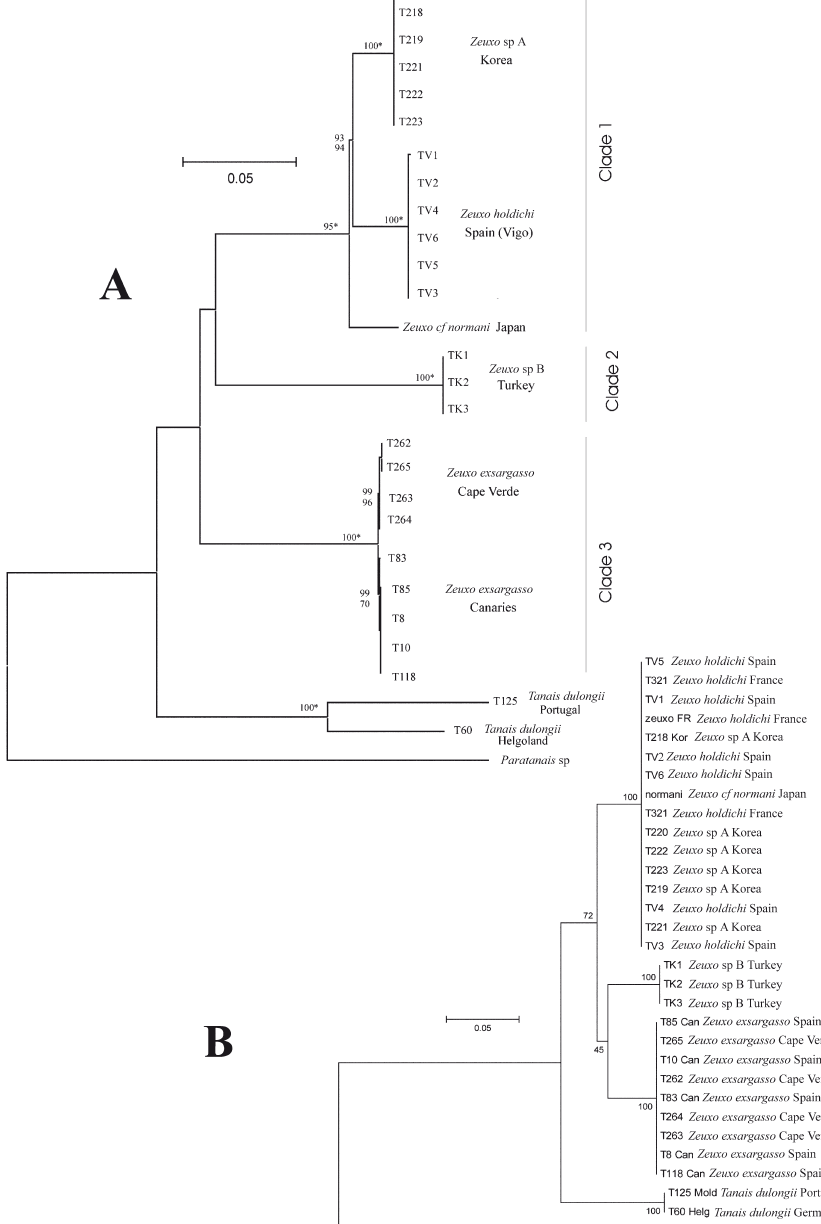
Fig. 1. – A, maximum likelihood (ML) tree inferred using the TVM+G model of sequence evolution showing relationships of Zeuxo spp. from different locations. The tree is rooted using Tanais dulongii and Paratanais sp. Bootstrap support values above 60% for the ML analysis are shown below nodes, and posterior probability values for the Bayesian analysis above nodes (see Materials and Methods). When the three analyses have the same value, they are represented by an asterisk (*). B, analysis for 28S only, including specimens from